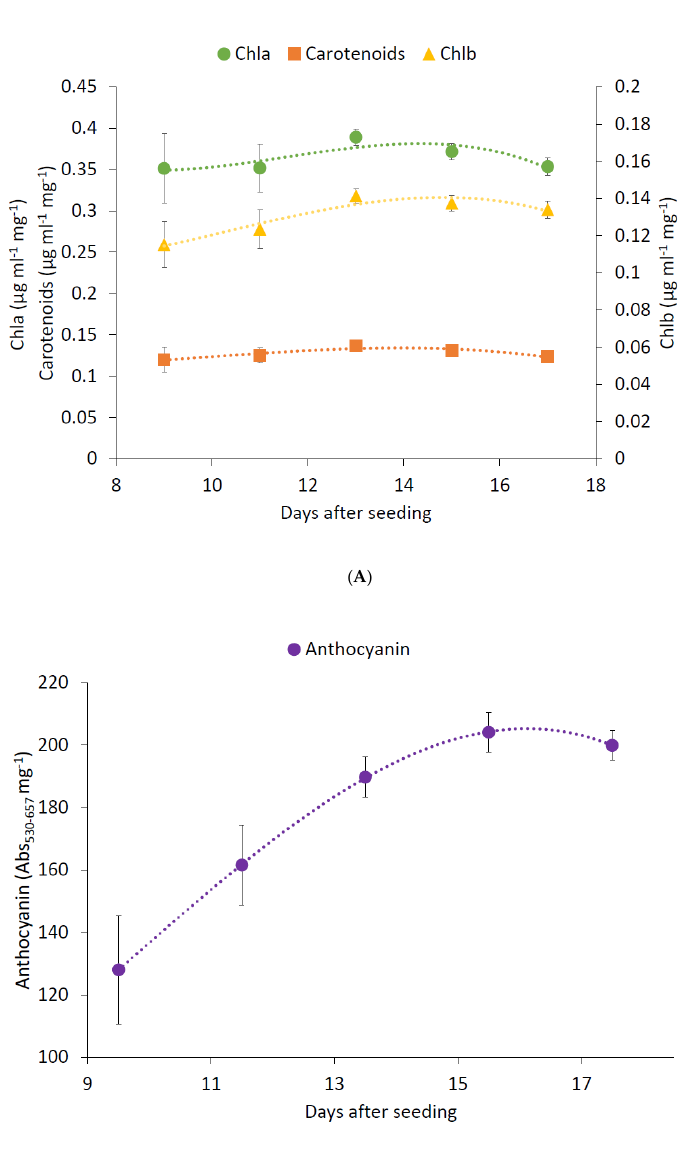
Figure 3. Chlorophyll ( A ) and carotenoid ( B ) concentrations in red lettuce ‘Rouxai’ plants during 17-day growth experiments. Values represent means from four experimental replicates ( n = 12). Error bars show standard errors of the mean (SEM). Error bars smaller than symbols are not